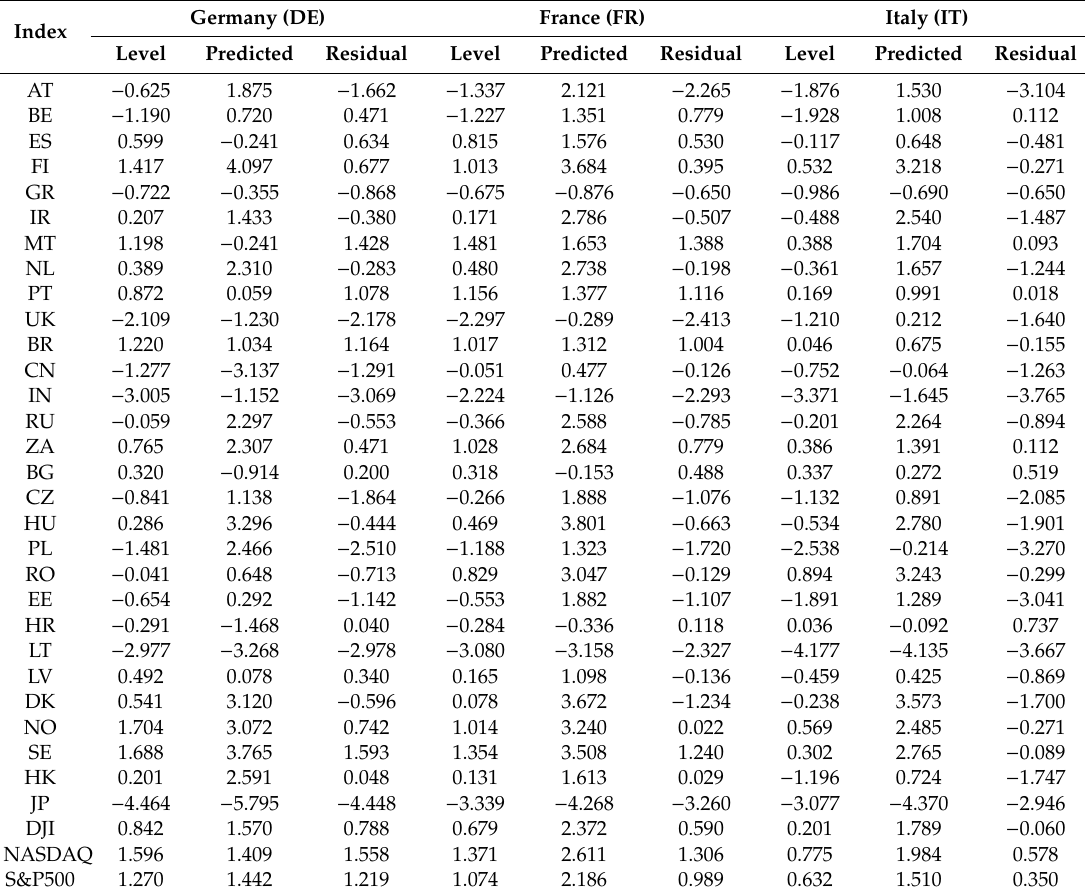
Table 5. T-test for contagion of EZC for lag Level, Predicted and Residual Series and Stock Index of Germany. France and Italy are sources of